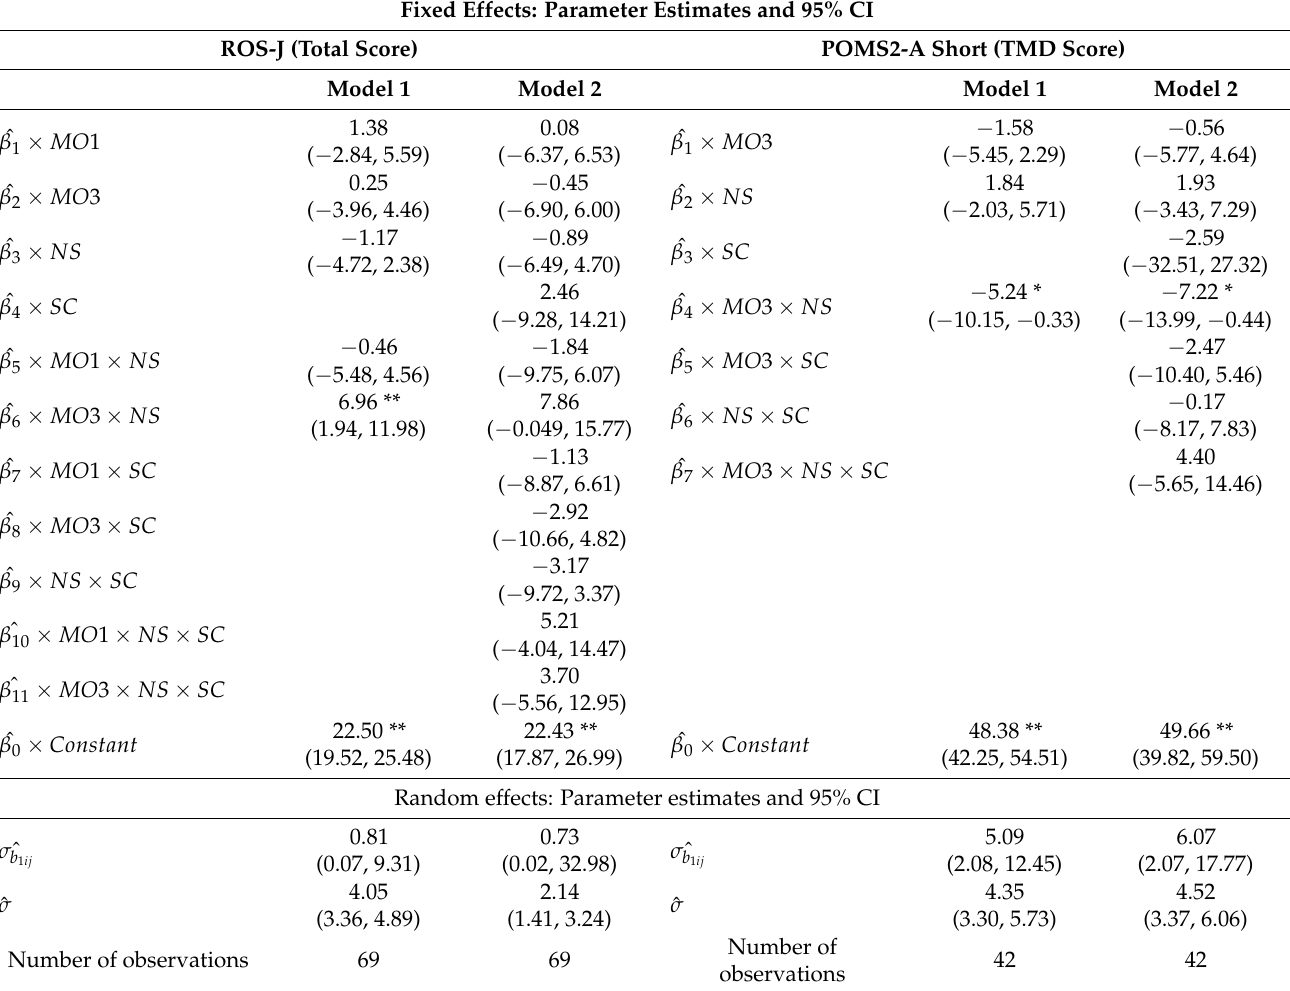
Table 3. Parameter estimates for the ROS-J total score and the POMS2-A Short TMD score. Fixed Effects: Parameter Estimates and 95%